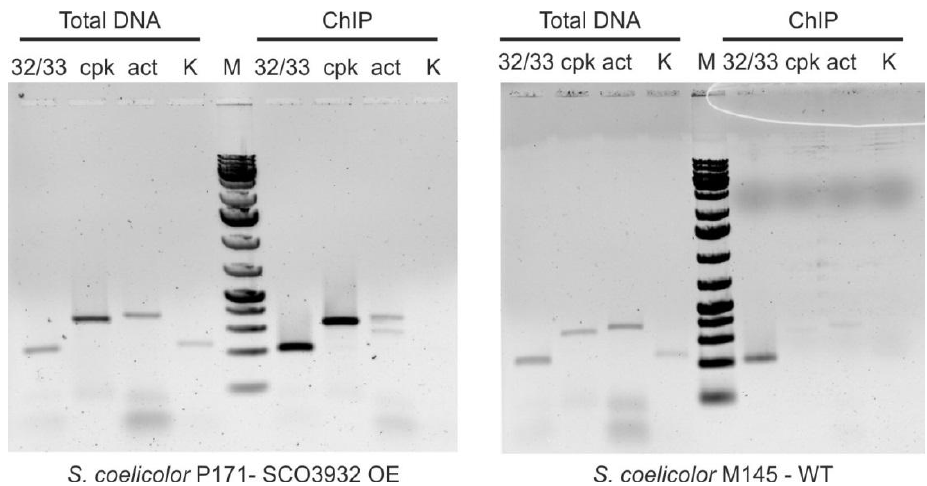
Figure 5. Chromatin immunoprecipitation. Nucleoprotein complexes crosslinked with glutaraldehyde were precipitated by anti ‐ SCO3932 polyclonal antibodies, and DNA fragments were amplified by PCR with primers listed in Table 2. SCO3932 overexpression in P171 was induced by thiostrepton (8 μ g/mL). 32/33—SCO3932/SCO3933 promoter, cpk— cpkD promoter,